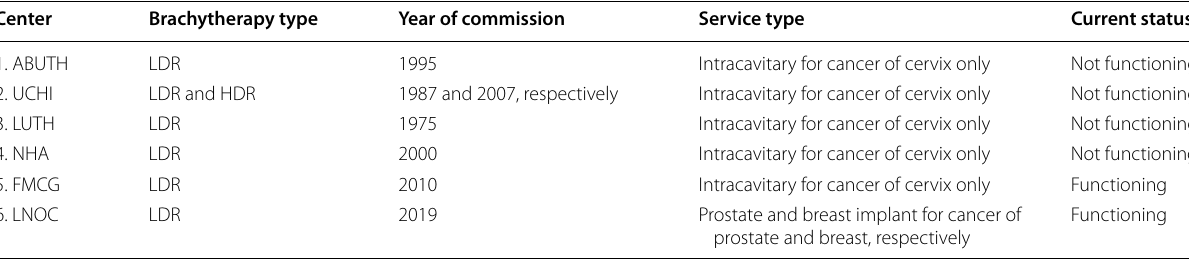
Table 1 Current distribution of brachytherapy machine in Nigeria